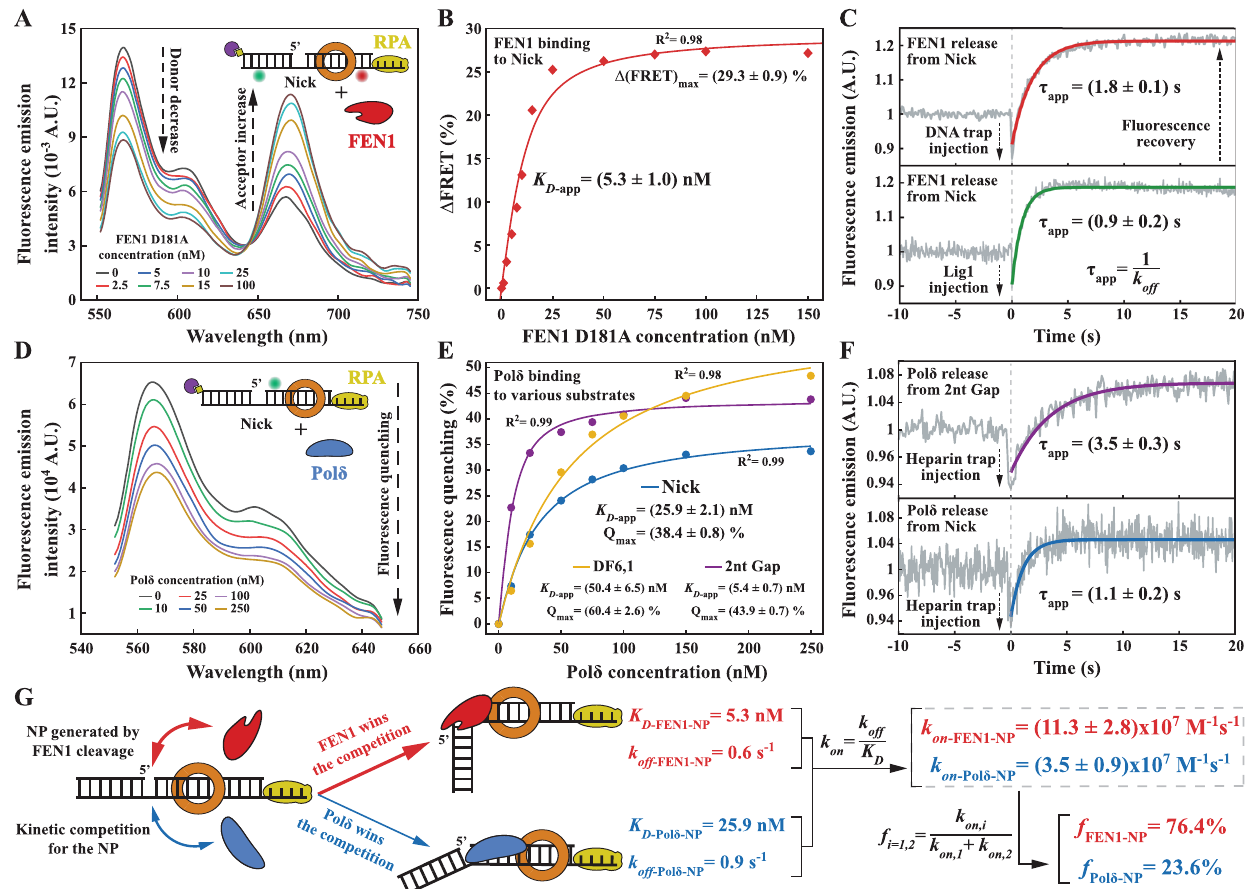
Fig. 5 | Kinetic competition between FEN1 and Pol δ for the NP. A Fluorescence emission spectra of internal labeled NP (Sub#24; Supplementary Fig. 7) in the presence of pre-loaded PCNA at various concentrations of FEN1 D181A. B Quanti fi cation of the data presented in panel A. The experimental datapoints were fi tted to a dependence proportional to Eq. (1) ( “ Methods ” ). C Fluorescence recovery of the Cy3 donor presented in panel A upon addition of a large excess of FEN1 DNA trap (top; 5 µ M of unlabeled phosphotiolated nonequilibrating double fl ap; Sub#31; Supplementary Fig. 7) or Lig1 (bottom; 2 µ M). The experimental datapoints were fi tted to Eq. (2) ( “ Methods ” ). D Fluorescence emission spectra of Cy3-labeledNP(Sub#28;SupplementaryFig.7)inthepresenceofpre-loadedPCNA at various concentrations of Pol δ . E Quanti fi cation of the data presented in panel D and of similar experiments in which the NP was replaced with either a 2-nt gap